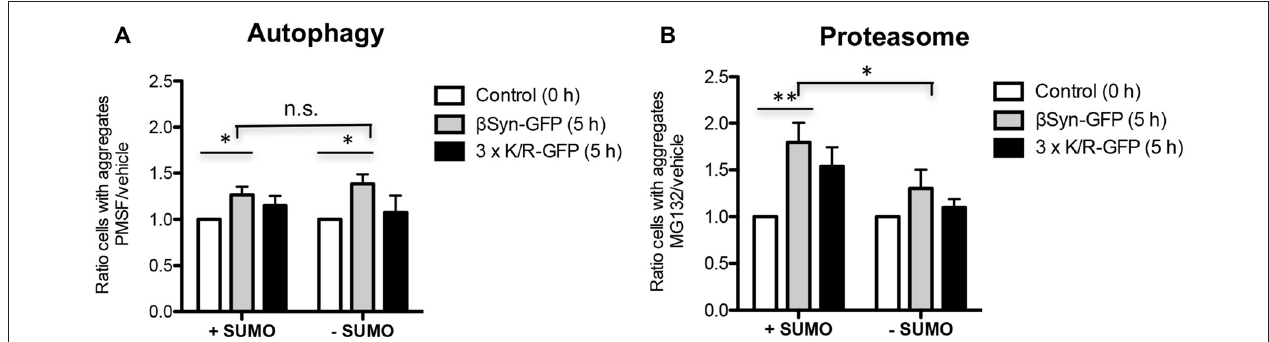
FIGURE 5 | β Syn aggregate clearance after promoter shut-off. Quantification of cells displaying aggregates of β Syn-GFP or 3xK/R-GFP upon inhibition of autophagy by phenylmethanesulfonyl fluoride (PMSF) (A) or proteasome by MG132 (B) . Yeast cells were incubated in 2% galactose-containing media for 4 h either at permissive (25 ◦ C; +SUMO) or restrictive temperature (30 ◦ C; − SUMO) and shifted to 2% glucose-containing media supplemented with 1 mM PMSF dissolved in EtOH (A) or 75 µ M MG132, dissolved in dimethyl sulfoxide (DMSO) (B) . Control cells were supplemented with vehicles only (EtOH or DMSO). Cells with aggregates were counted after 5 h GAL1 -promoter shut-off and presented as a ratio to the control. Significance of differences was calculated with t -test ( ∗ p < 0.05; ∗∗ p < 0.01; n = 4).